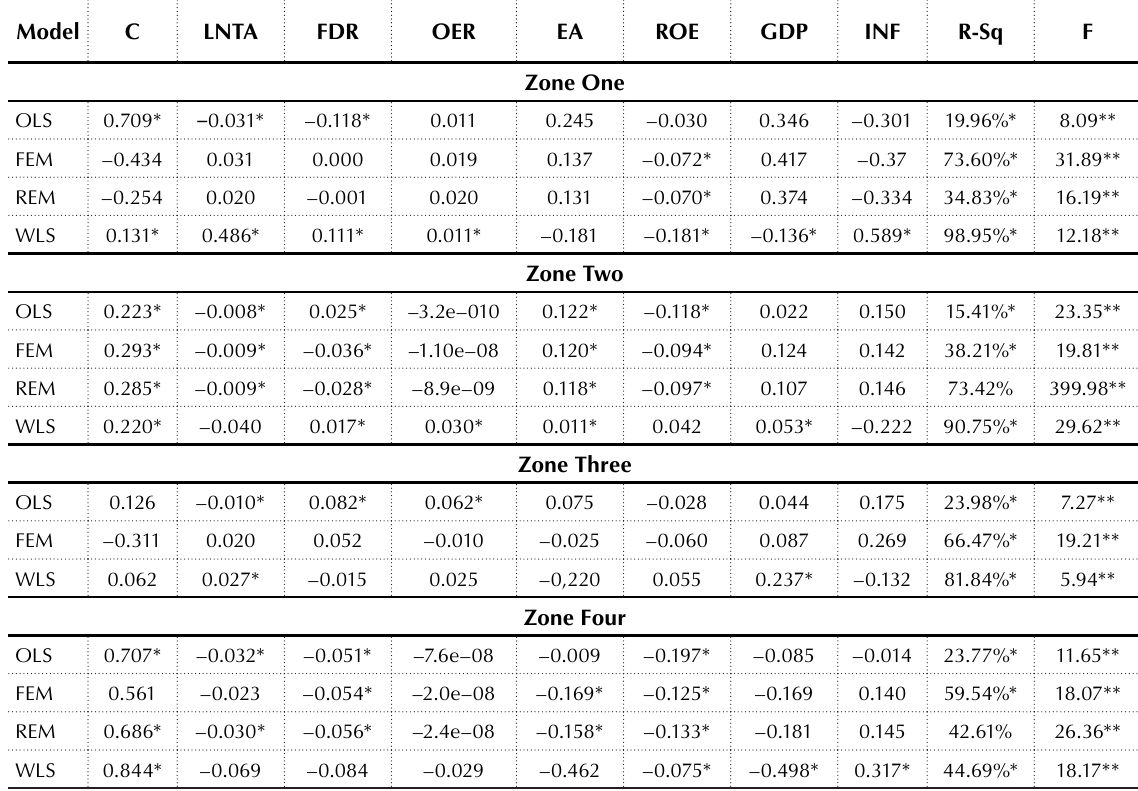
Table 2. NPF model by working zones